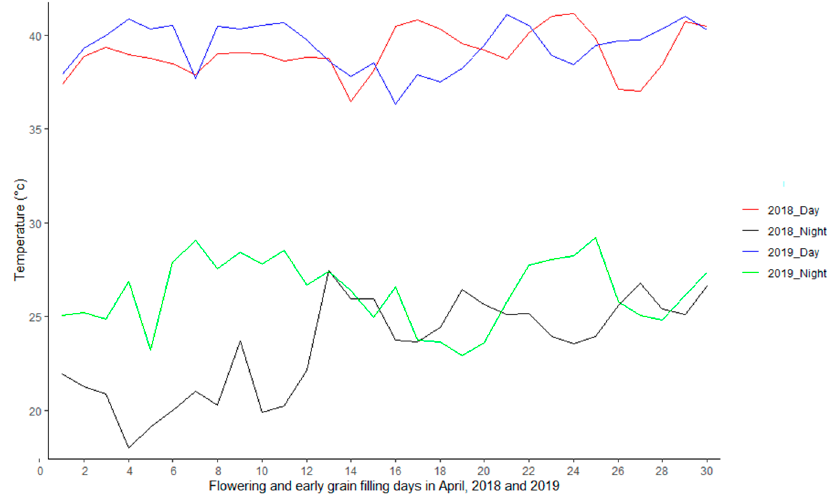
Figure 2. Average temperature (night and day) at Kadawa during flowering and early grain filling in 2018 and 2019.